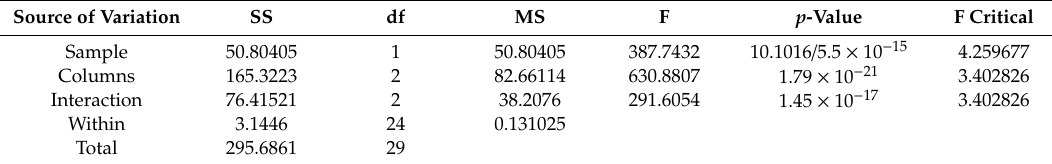
Table 6. Results of two-factor ANOVA with replication.